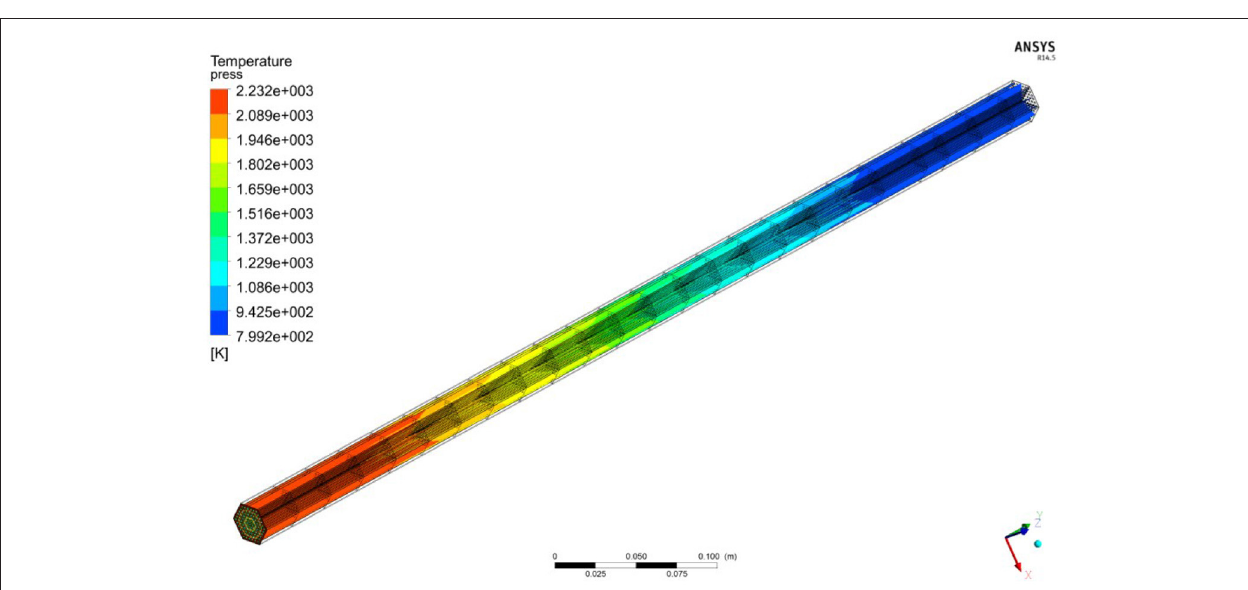
FIGURE 10 | Axial temperature profile of the average channel for 91 coolant channel fuel element.